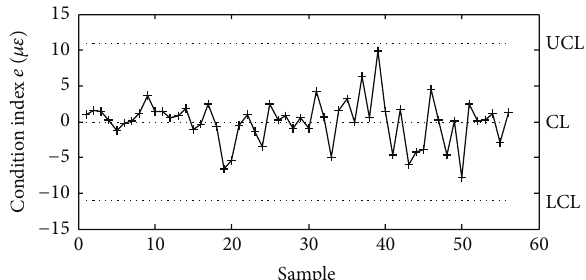
Figure 17: Mean value control chart for static strains of the steel truss arch.